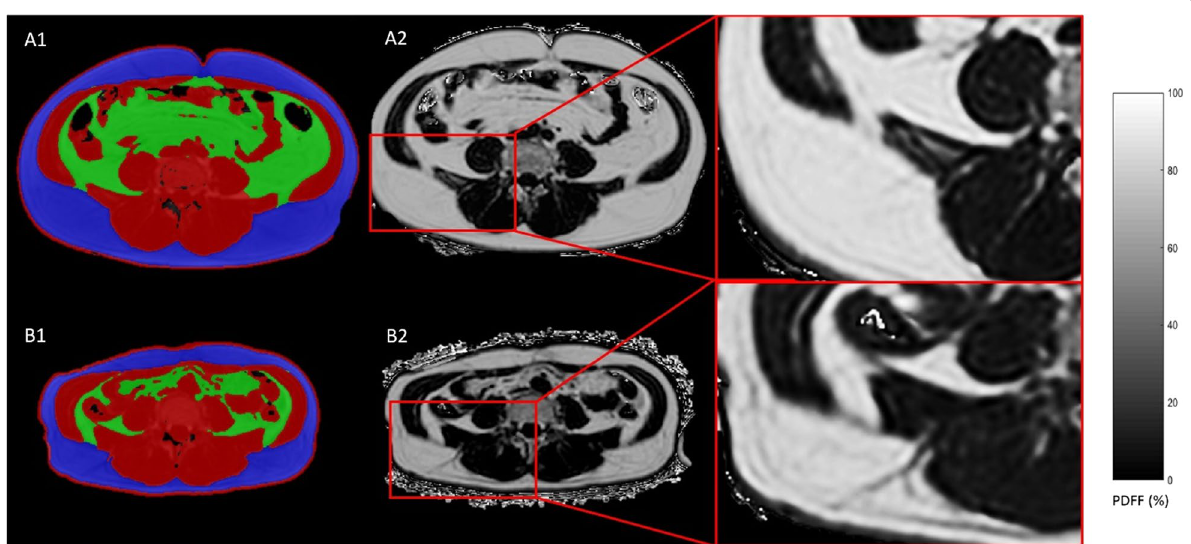
Fig. 4 Adipose tissue changes in a patients with cancer cachexia: axial abdominal MRI images of a 54 year-old male subject with esophageal cancer at baseline ( A ) and follow-up after 8 months ( B ). A1 , B1 Color-coded are VAT (green), SAT (blue) and non-adipose tissue (red). A2 , B2 Corresponding PDFF maps showed a decrease in VAT from 83 to 72% and SAT from 87 to 76%. The BMI decreased from 30.2 to 24.1 kg/m2. BMI body mass index, PDFF proton density fat fraction, VAT visceral adipose tissue, SAT subcutaneous adipose